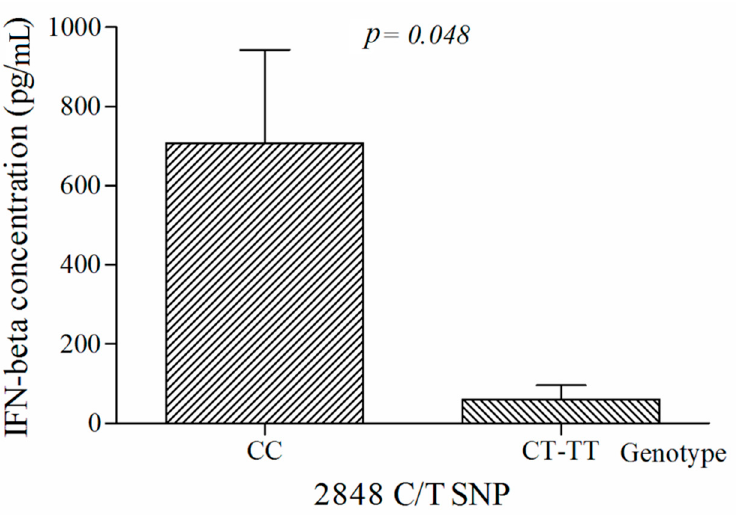
Figure 2. Interferon- β (IFN- β ) levels by TLR9 2848C/T SNP in HIV/CMV co-infected patients. Bars represent the mean values and standard error of the mean (mean ± SEM) of the IFN- β concentration. p < 0.05 via a Mann-Whitney U test.